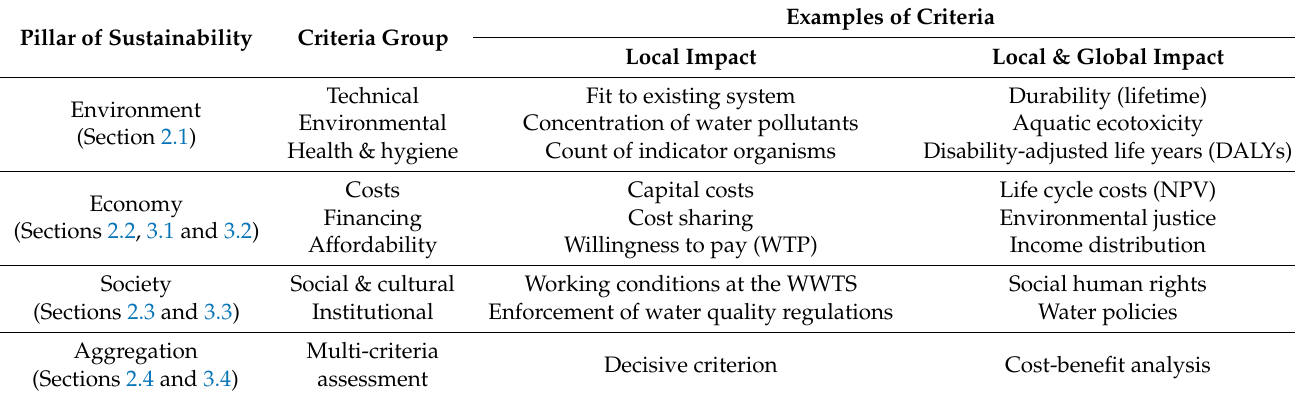
Table 1. Organization of criteria for the presentation in this